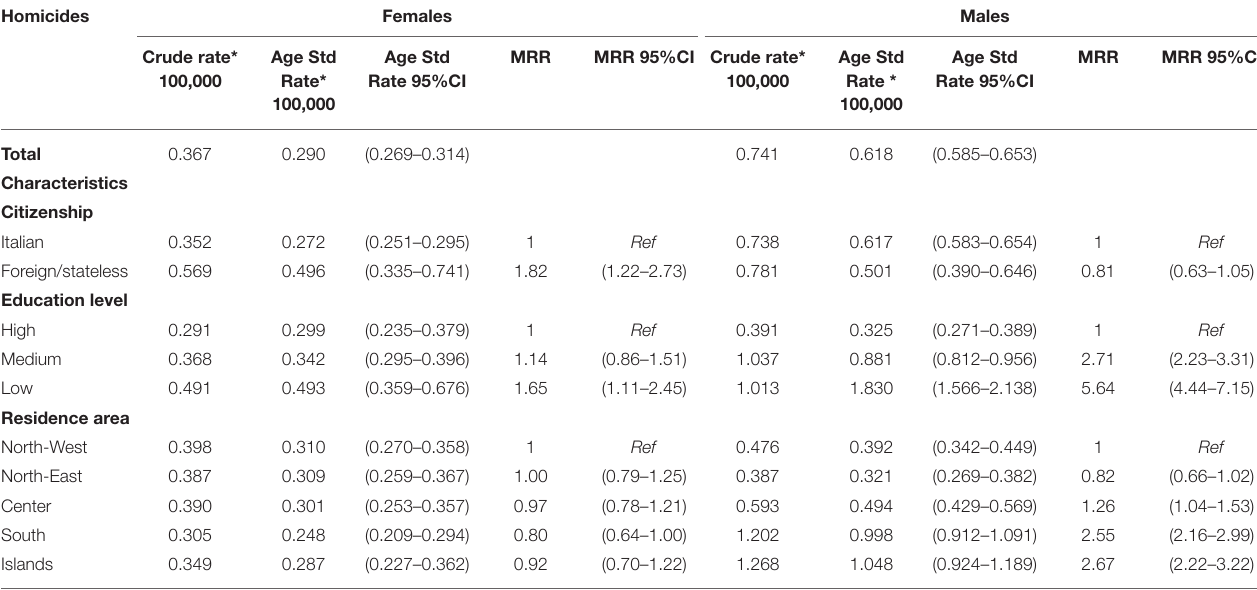
TABLE 2 | Homicide mortality: crude and age-standardized rates *100,000 and mortality rate ratios (MRR) with 95% CI, by citizenship, education level, and residence area. Homicides